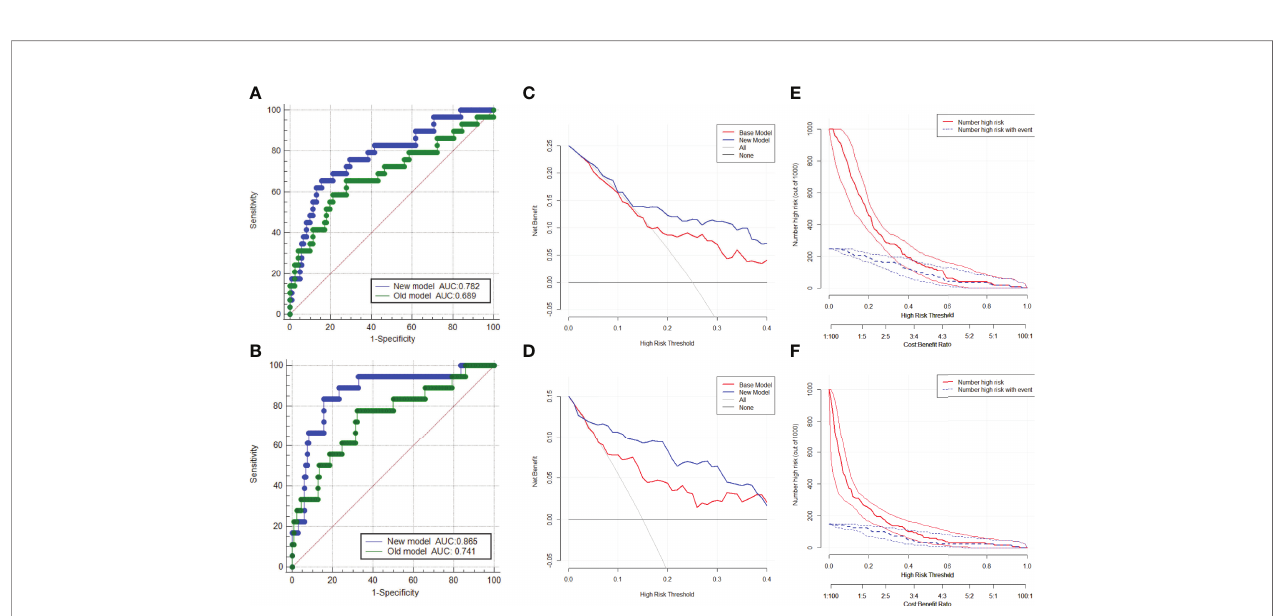
FIGURE 5 | ROC curves of the two models in the diagnosis of (A) PCa and (B) csPCa in biopsy-naïve men with PIRADS v2 categories 3. Decision curve analysis of the two models for predicting the occurrence of (C) PCa and (D) csPCa in biopsy-naïve men with PIRADS v2 categories 3. Clinical impact curves of the two models for the diagnosis of (E) PCa and (F) csPCa in biopsy-naïve men with PIRADS v2 categories 3. AUC, area under the curve; ROC, receiver operating characteristic; PCa, prostate cancer; csPCa, clinically signi fi cant prostate cancer; PIRADS, Prostate Imaging Reporting and Data